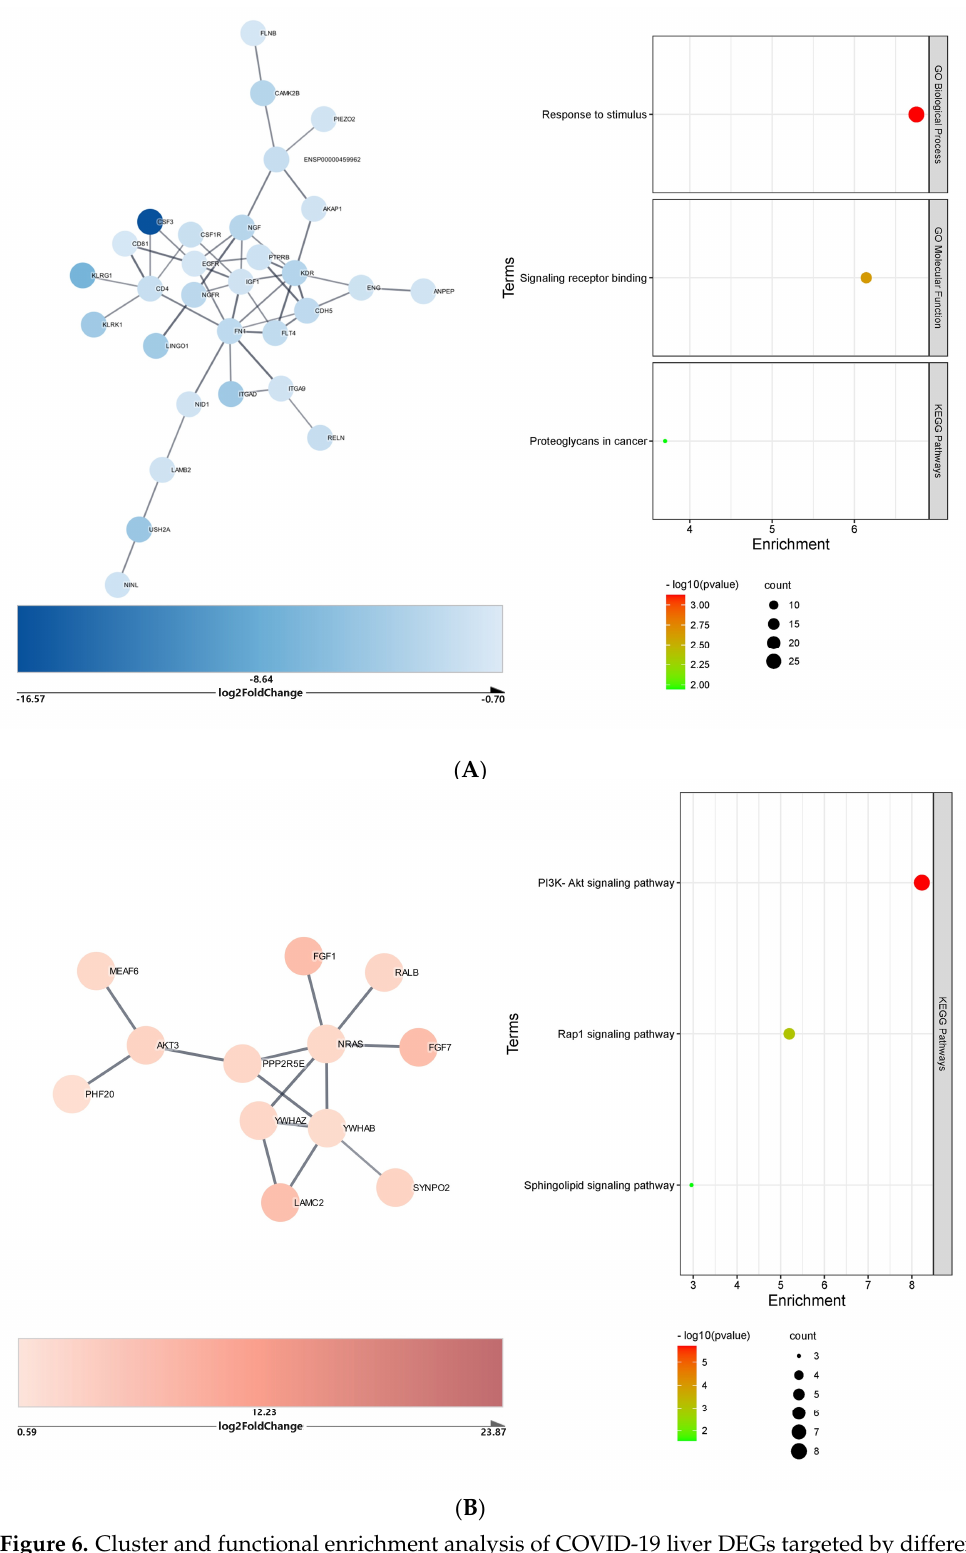
Figure 6. Cluster and functional enrichment analysis of COVID-19 liver DEGs targeted by differentially expressed microRNAs: STRING interaction confidence score > 0.7; Markov clustering inflation value = 4; STRING Enrichment FDR < 0.05; redundancy score = 0.5. ( A ) Cluster and functional enrichment analysis of COVID-19 liver downregulated DEGs targeted by upregulated microRNAs. ( B ) Cluster and functional enrichment analysis of COVID-19 liver upregulated DEGs targeted by downregulated microRNAs.